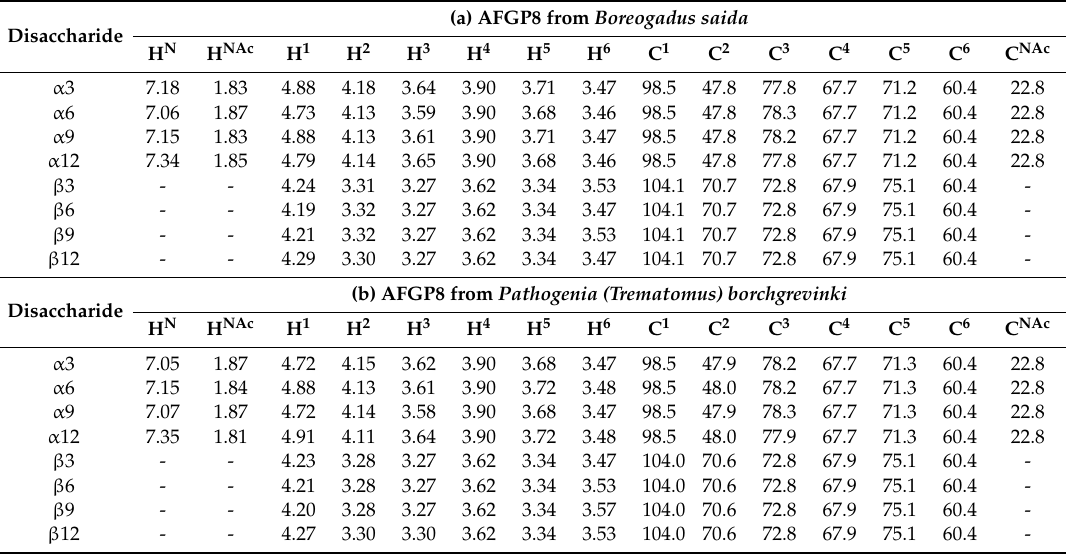
Table 2. Chemical Shifts of the Disaccharides on